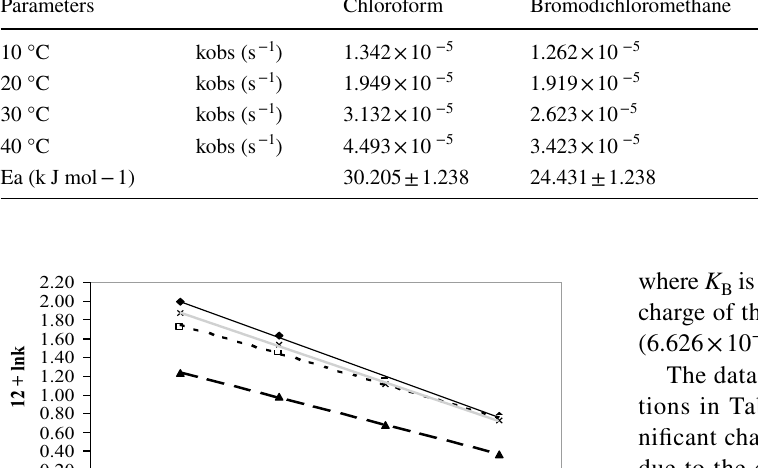
Table 2 Pseudo-first-order rate constant ( k mol −1 ) Parameters